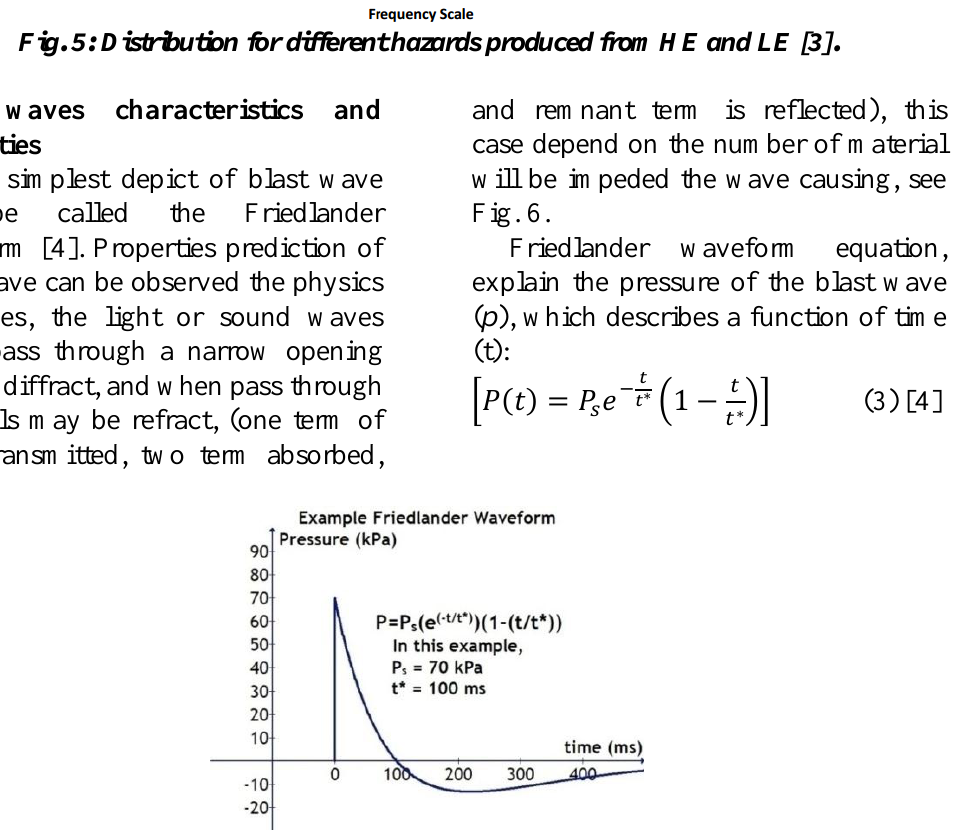
Fig. 6: A Friedlander wave form is explanation rapid transition pressure with the time